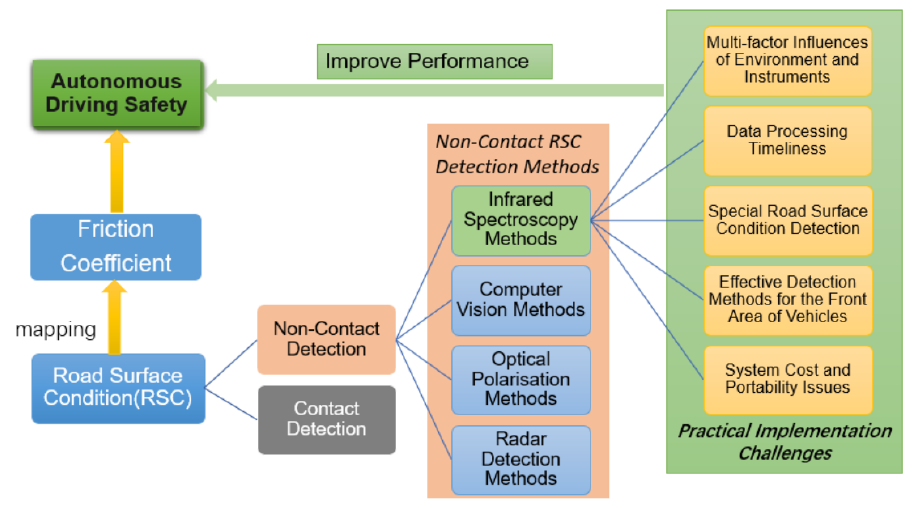
Figure 1. Structure diagram of this